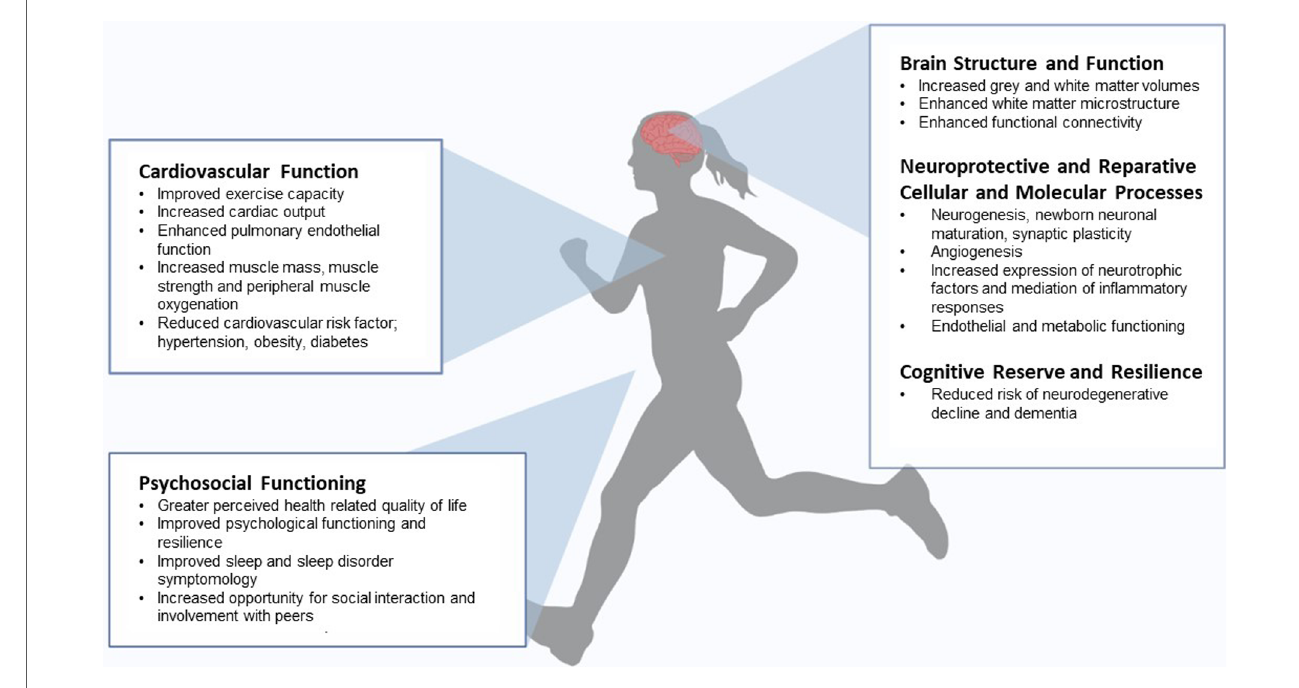
FIGURE 2 Multi-level factors associated with exercise and improved cognitive